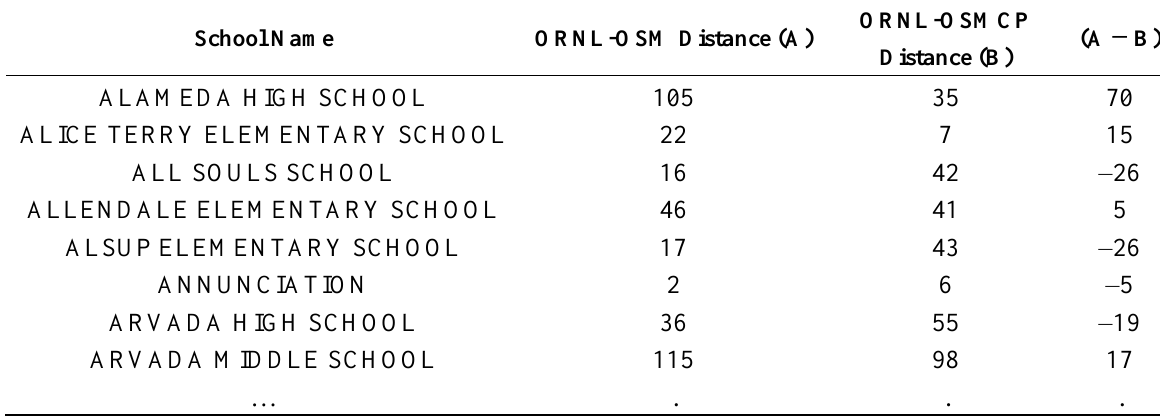
Table 7. Data sampling of distance differences for matched schools.